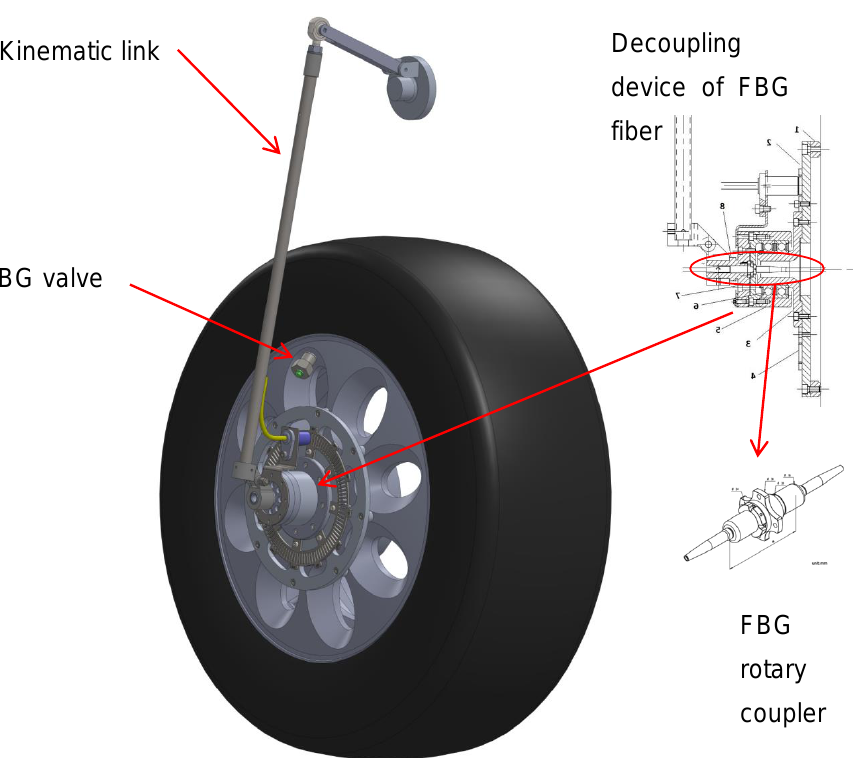
Figure 5. Computer Aided Design-CAD of the wheel with in evidence the FBG valve, the FBG rotary coupler and the kinematic link.